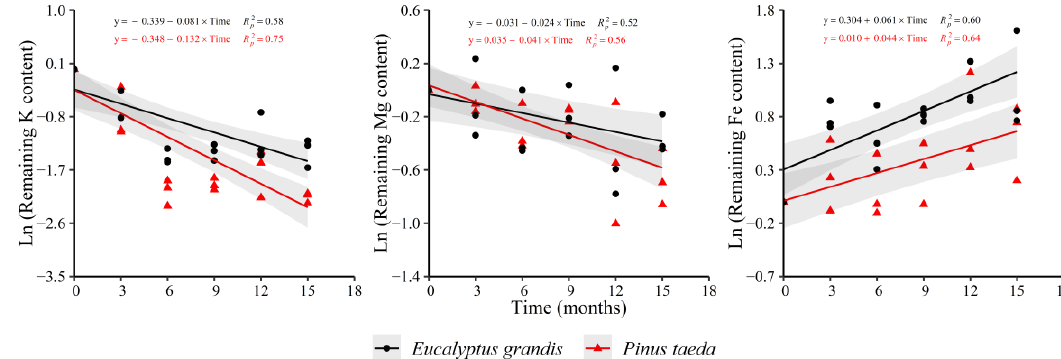
Figure 7. Remaining nutrient content of E. grandis (black symbols) and P. taeda (red symbols) litter for the different sampling moments (C3 layer). The gray bands around the models represent the 95% confidence interval.